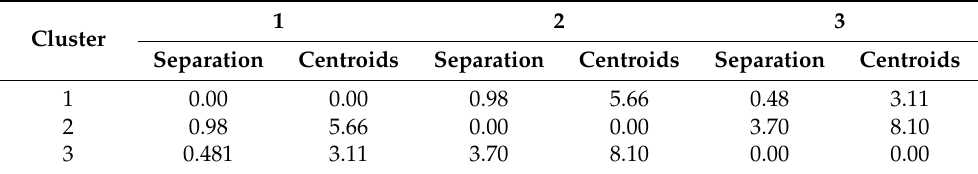
Table 1. Matrix of separation values between all pairs of clusters and distance between centroids. 1 2 3 Cluster Separation Centroids Separation